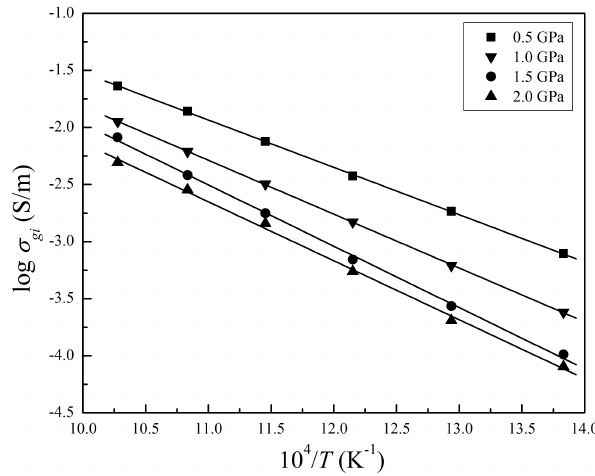
Figure 3. Bode plot of dependence of modulus and phase angle on frequency quartz andesite under conditions of 1.0GPa and 723– 973K.